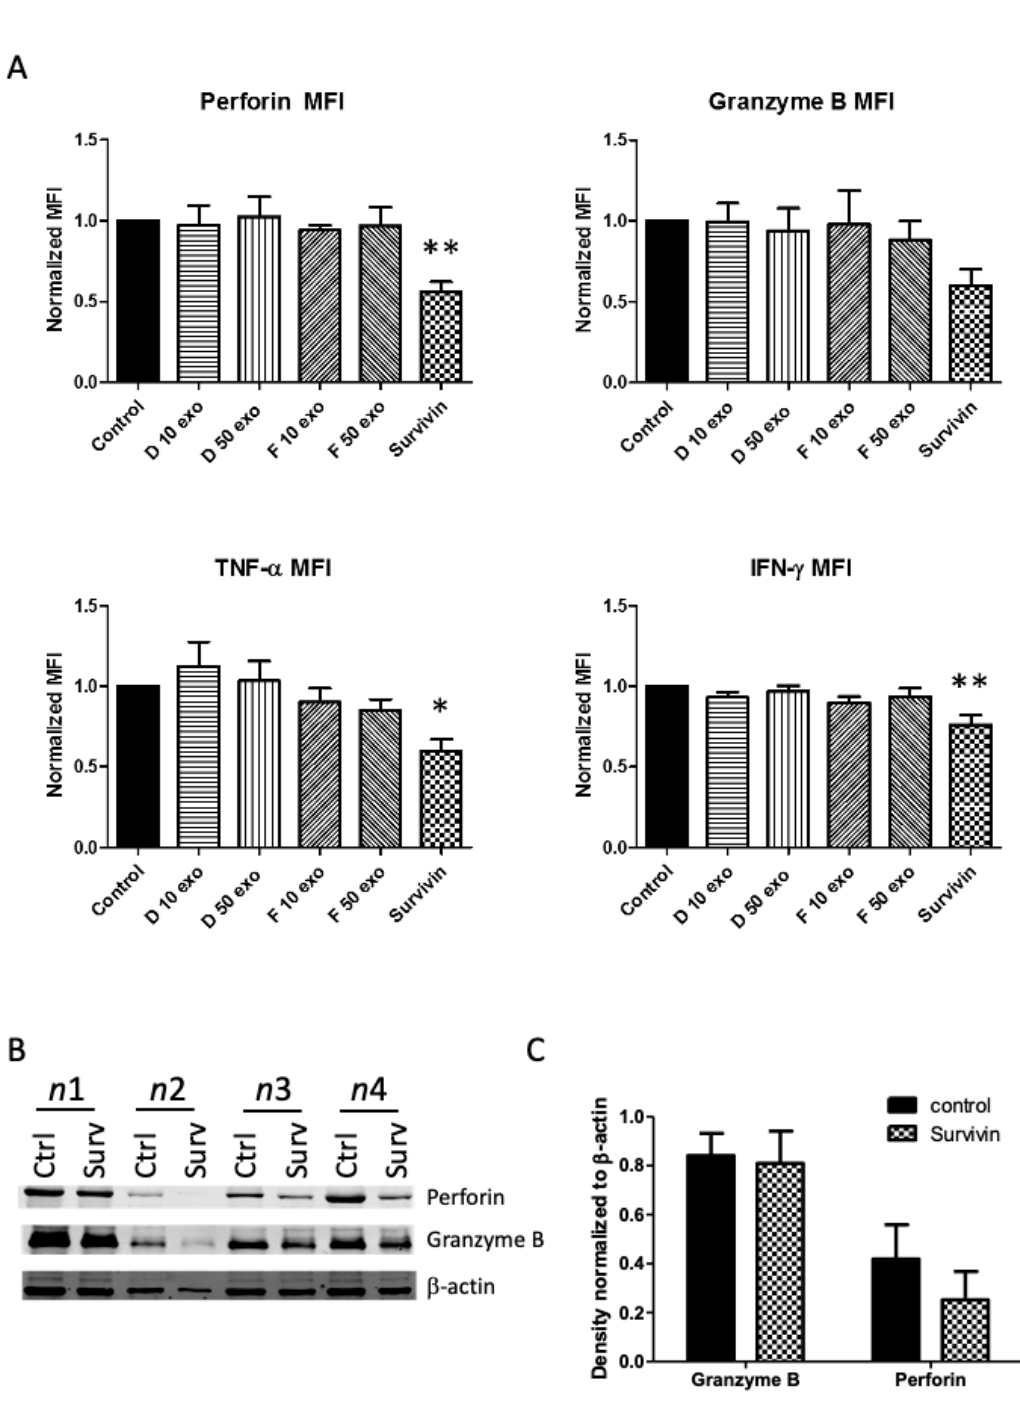
Figure 5. Survivin decreased NK cell intracellular protein levels of perforin, granzyme B, TNF- α , and IFN- γ . ( A ) CD3-, CD56+ NK cells were treated with extracellular survivin protein (0–1.0 µ g/mL) or lymphoma exosomes (10–50 µ g/mL) for 24 h. Expression of perforin, granzyme B, TNF- α , and IFN- γ was measured by intracellular flow cytometry ( n = 5). Two concentrations of exosomes were investigated (10 µ g and 50 µ g). MFI was normalized to an untreated group and data are presented as mean ( ± SEM) of five independent experiments (* is p < 0.05, ** is p < 0.01), survivin treatment versus untreated control. ( B ) Western blot analysis, in order to determine protein levels of perforin and granzyme B, was conducted (x4) from NK cells after treatment with survivin. ( C ) Densitometry by ImageJ with b-actin normalization ( n =